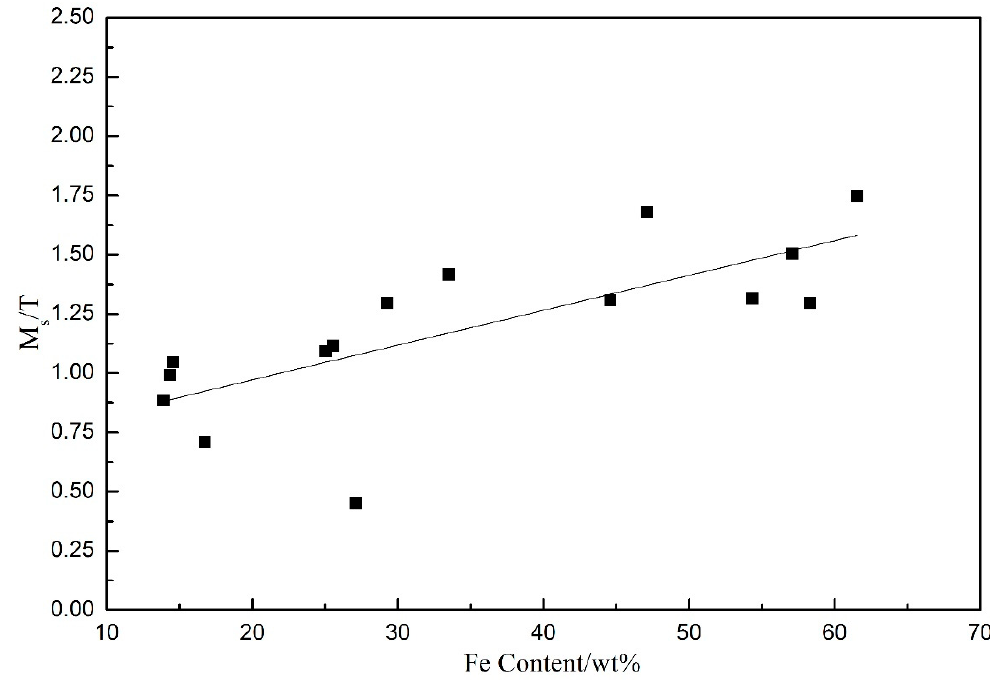
Figure 9. The relationship between saturation magnetization (Ms) and Fe content in FeNi electrode- posited films.